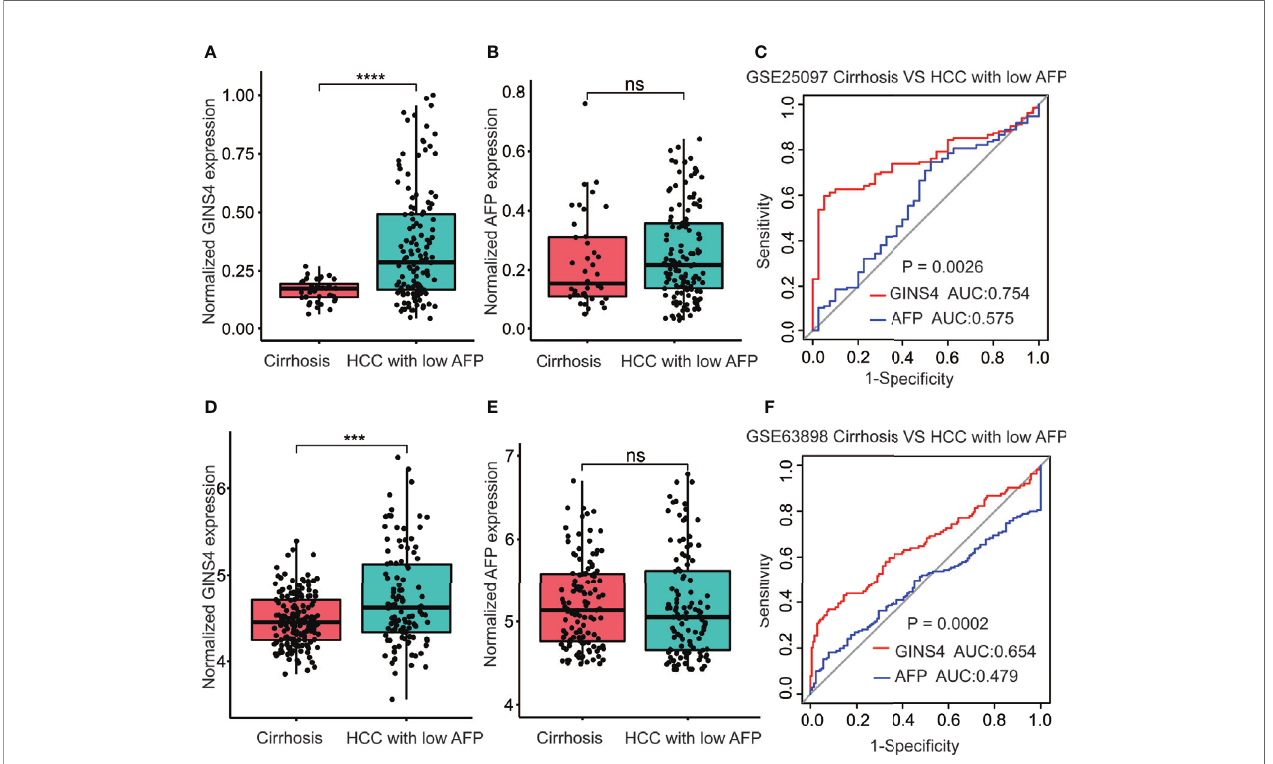
FIGURE 7 | GINS4 harbors a satisfactory performance to distinguish low AFP-expressing HCC from liver cirrhosis. GINS4 expression level between liver cirrhosis and low AFP-expressing HCC from (A) GSE25097 and (D) GSE63898. AFP expression level between liver cirrhosis and low AFP-expressing HCC from (B) GSE25097 and (E) GSE63898. ROC curve reveals the capability of GINS4 and AFP in differentiating liver cirrhosis and low AFP-expressing HCC from (C) GSE25097 and (F) GSE63898. (***P < 0.001, ****P < 0.0001). ns, no signi fi cance; ROC, the receiver operating